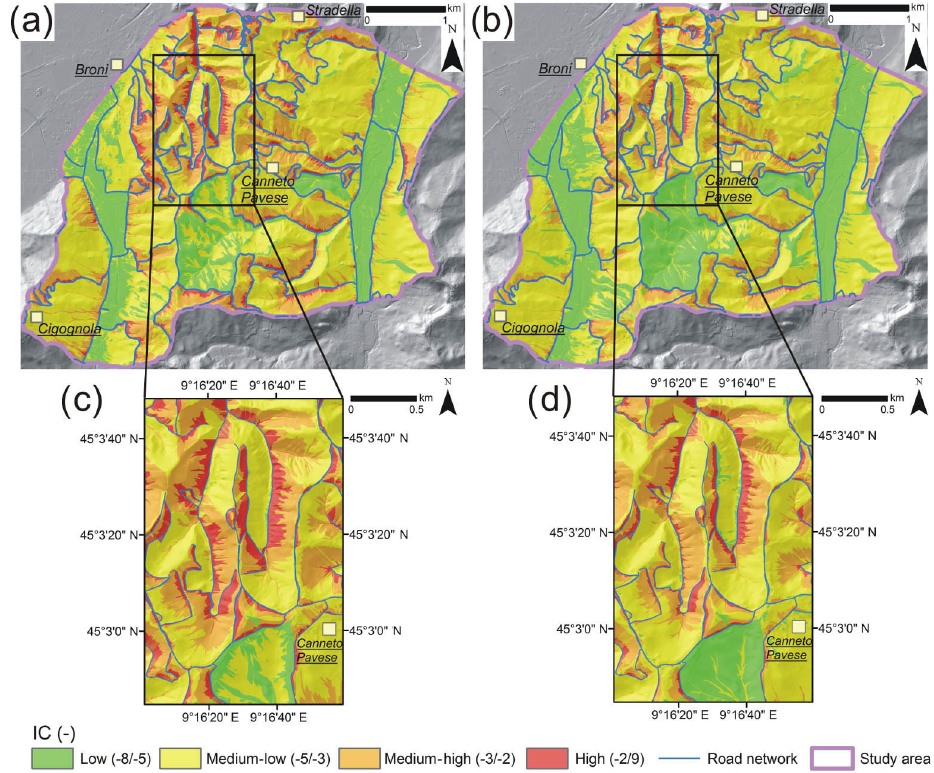
Figure 6. Actual (2015) IC maps corresponding to the linear calculation of the index since W lin (a) and to the non-linear calculation of the index since W nl (b) . A detail of the northern sector of the study areas is reported for IC lin (c) and IC nl (d)